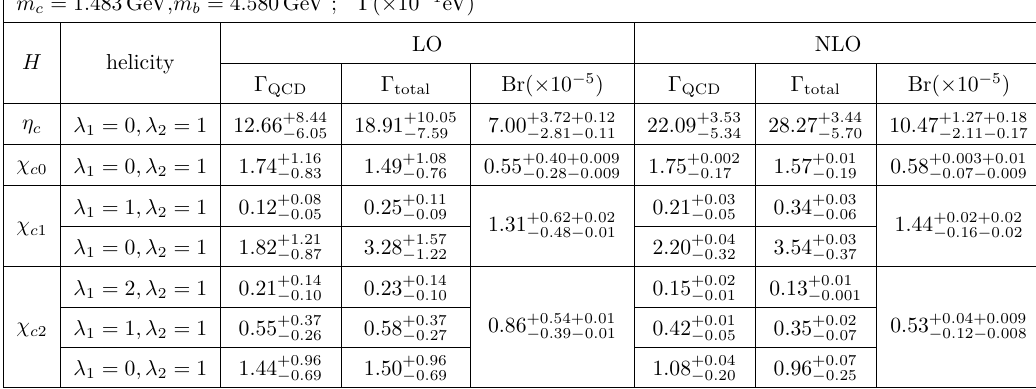
Table 3 . NRQCD predictions on the helicity decay widths and branching fractions of Υ → H + γ at LO and NLO in α s for m c = 1 . 483 GeV and m b = 4 . 580 GeV. The LDMEs are evaluated through the BT potential model. Γ QCD represents the pure QCD contribution, and Γ total denotes the sum of QCD, QED and the interference, where we compute the QED contribution in the QED We include the uncertainties from the renormalization scale in both the decay widths and the branching fractions. In addition, we also include the uncertainties (the second entry) originating from Γ Υ and f Υ .